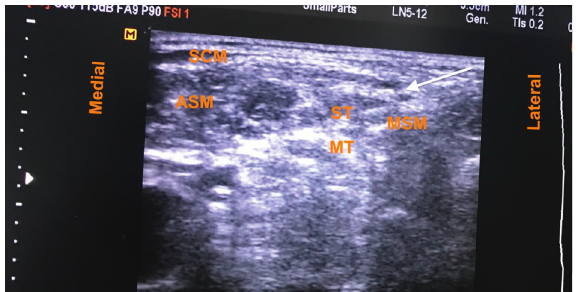
Figure 2: Preliminary scan showing brachial plexus in the inter- scalene groove. Arrow indicates needle direction. Abbreviations: ASM, anterior scalene muscle; LA, local anesthesia; MSM, middle scalene muscle; MT, middle trunk; ST, superior trunk; SCM, sternocleidomastoid